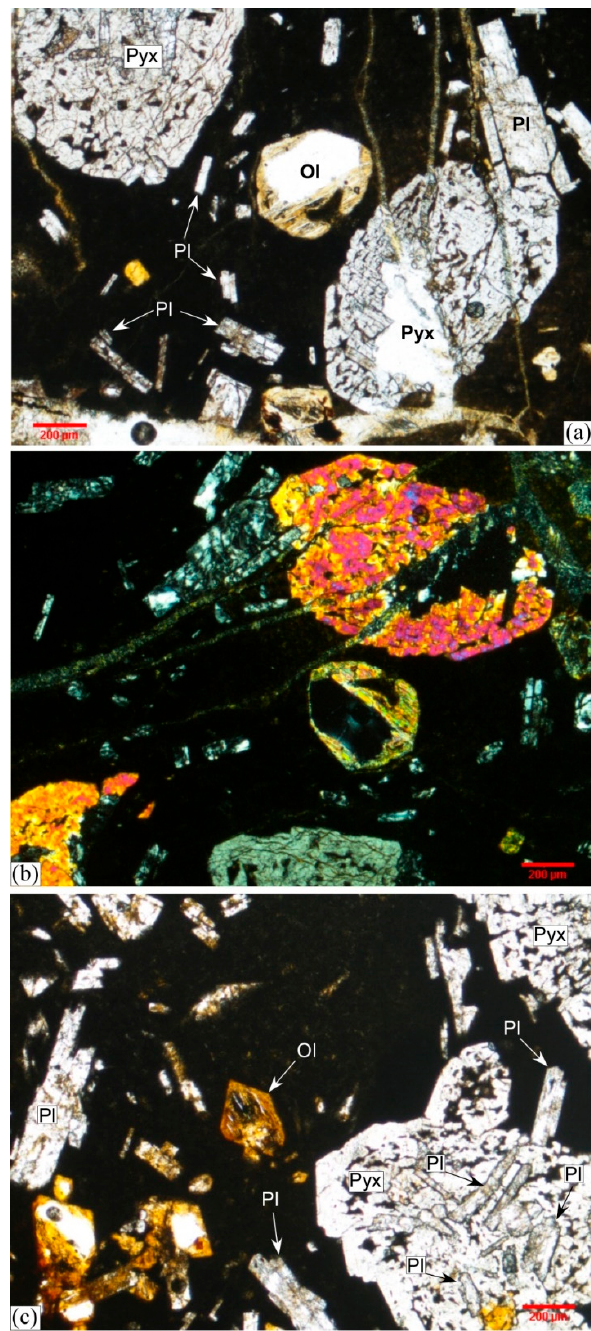
Figure 8. Photomicrograph in ( a ) PPL (plane polarized light) and ( b ) XPL (crossed polarized light) showing olivine (Ol), pyroxene (Pyx) and plagioclase (Pl) phenocrysts floating in a vitrophyric groundmass. ( c ) Olivine basalt preserving ophitic and subophitic textures.